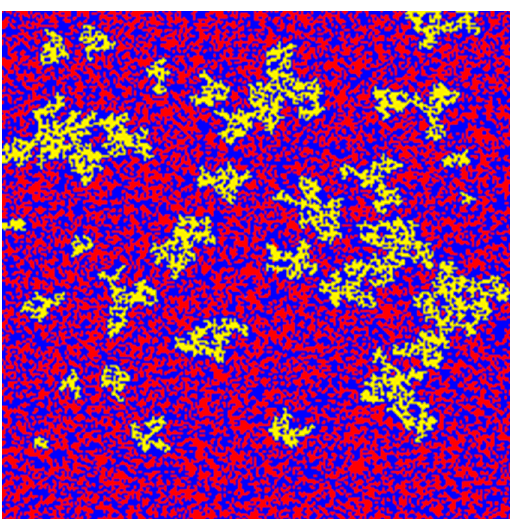
Figure 3. An example of the distribution of random fields h i ( R = 1.00) in the 2D model space (200 by 200 spins). Each pixel/square of the image represents a single spin operator; positive values of the random field ( h i > 0) are marked in red, while negative ones ( h i < 0) are marked in blue. Some clusters are exceptionally highlighted in yellow to show their geometry.